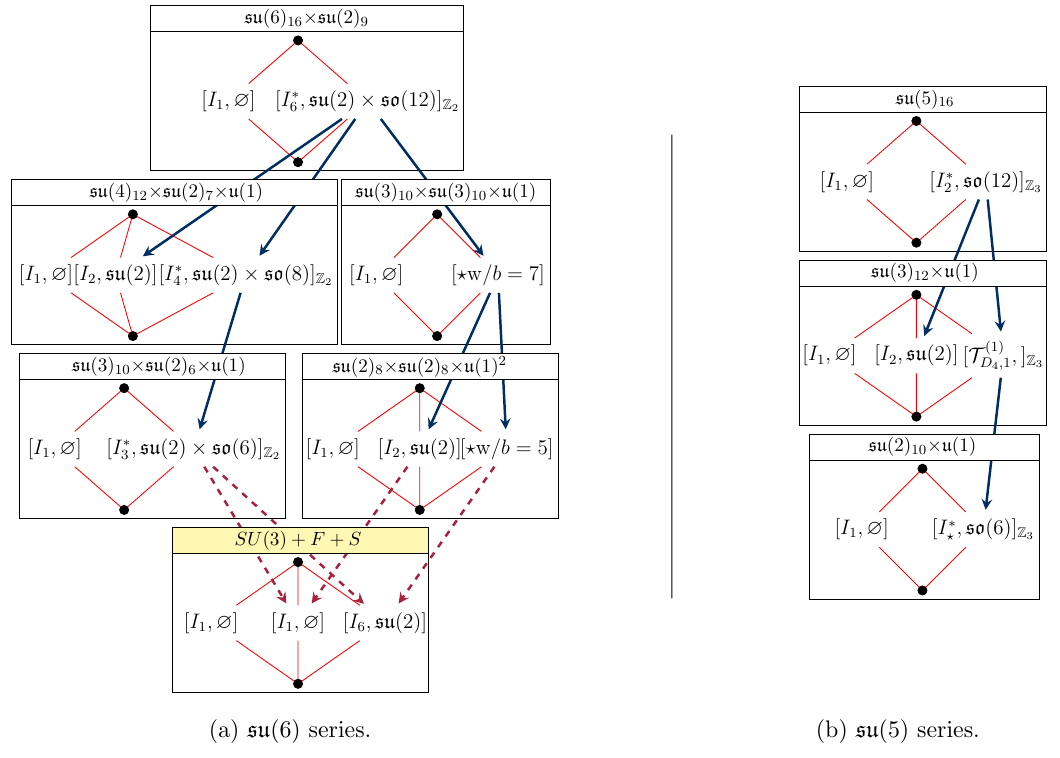
Figure 9 . Coulomb branch analysis of the mass deformations among the entries of the ( a ) su (6) and ( b ) su (5)